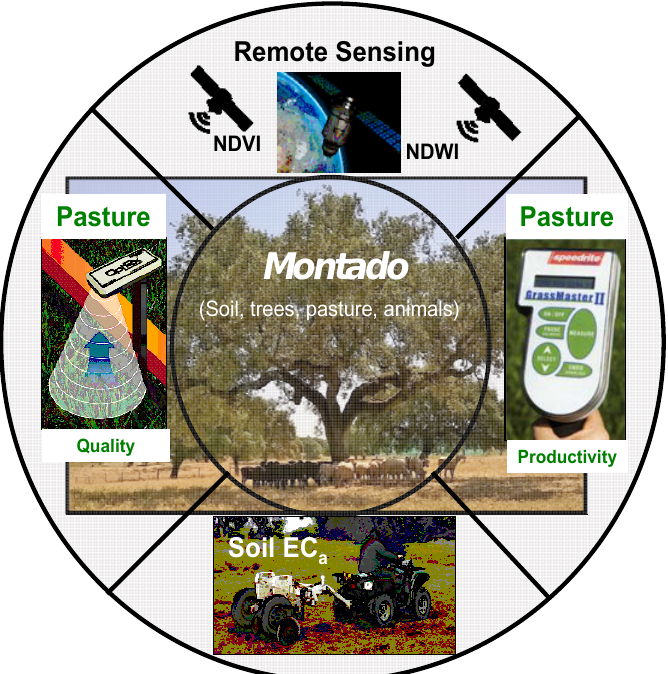
Figure 13. Proposed approach to monitoring soil and pasture of the Montado ecosystem based on proximal and remote sensing.